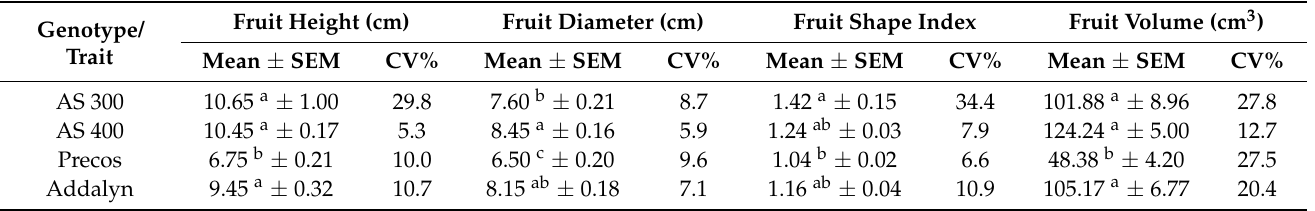
Table 1. Main physico-morphological attributes of the fruits and their coefficients of variability (CV%) in the four F1 commercial hybrids.